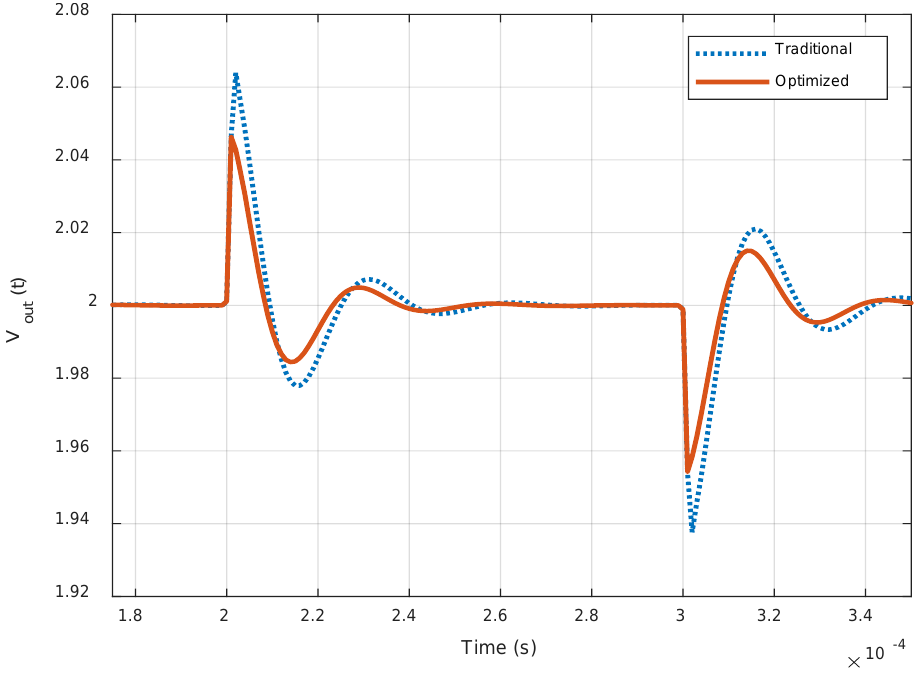
Figure 9. Load transient response.